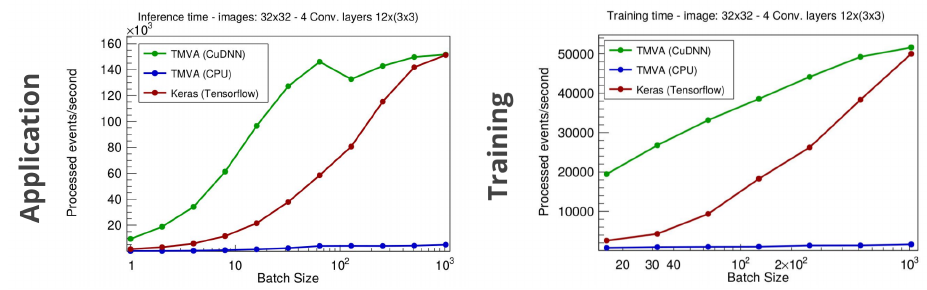
Figure 6. Benchmark of the convolutional NN in TMVA versus TensorFlow interfaced by Keras for training and